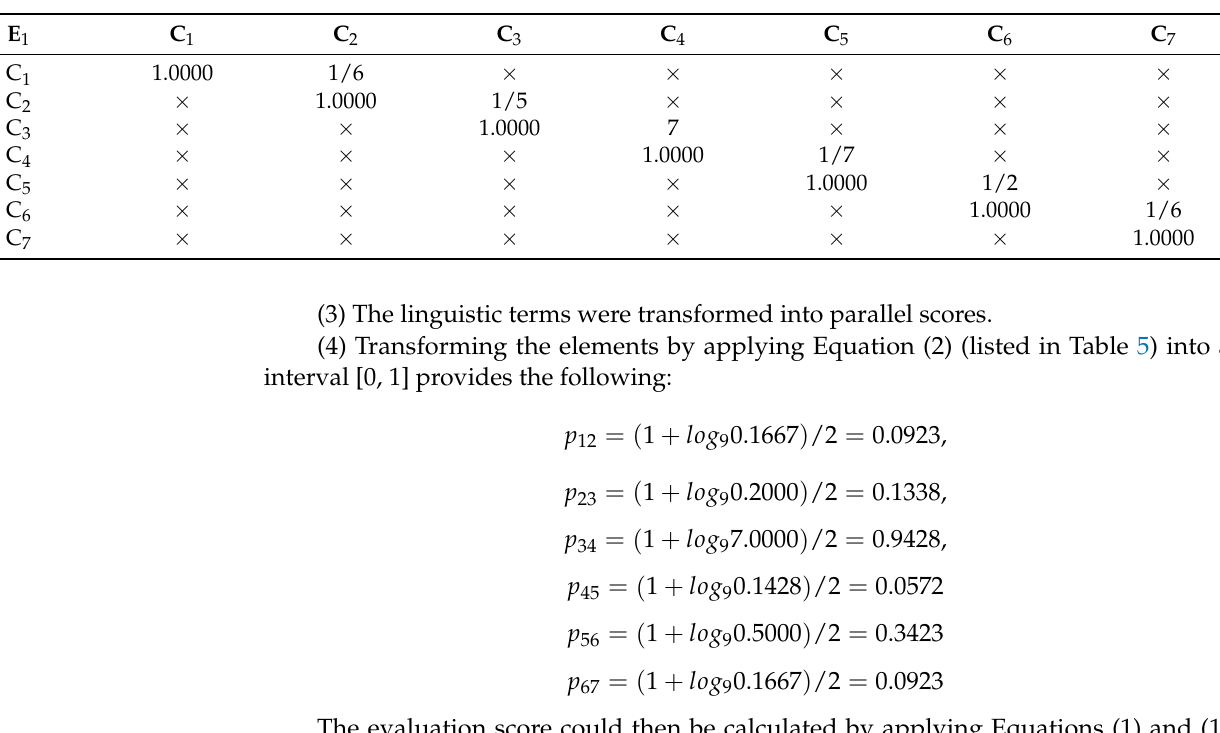
Table 6. Linguistic terms transformed into parallel scores in Taiwan.